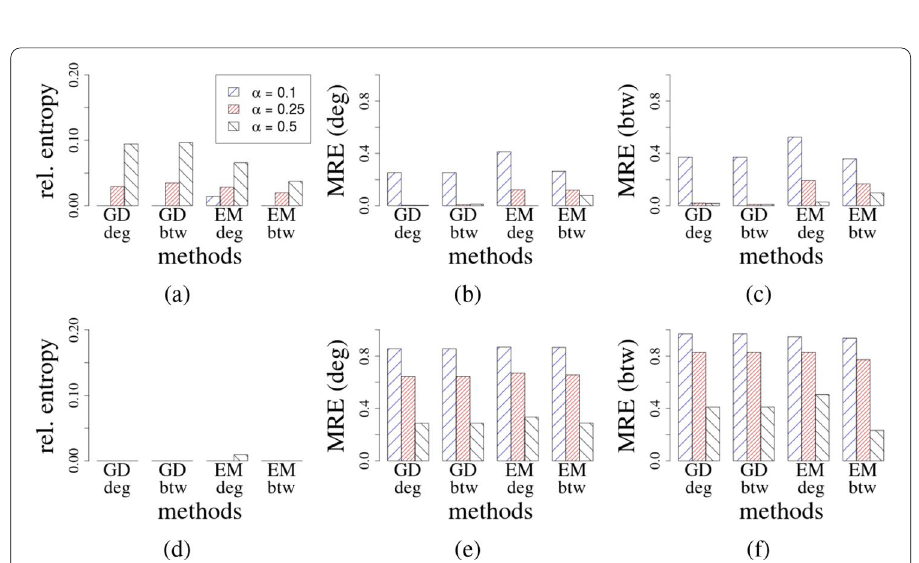
Fig. 11 Beta distributions: relative entropy (column one), mean relative error of expected degree (column two) and mean relative error of expected ego betweenness (column three) of sparsified Erdős–Rényi graphs with 500 nodes and density ρ = 0.5 . Edge probabilities are assigned according to a Beta distribution with (row 1) B ( 1,4 ) and mean 0.2, and (row 2) B ( 7,3 ) and mean = =